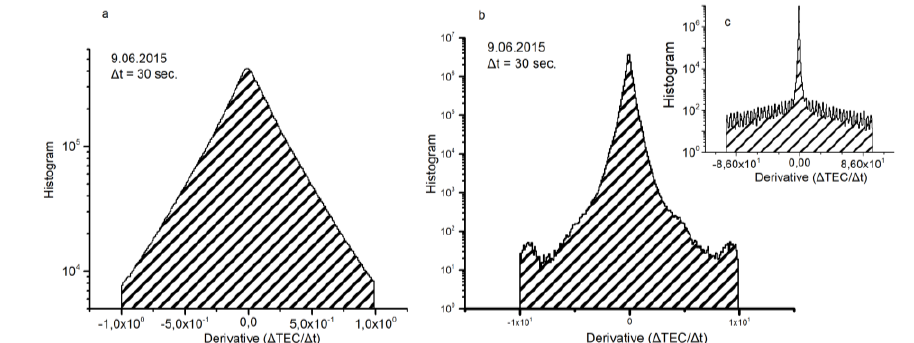
Fig. 2. The distribution of the values of the time derivative of the phase signal TEC on different